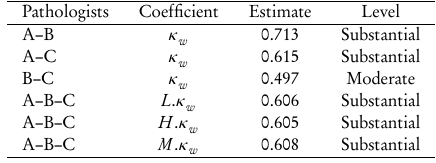
The results of weighted kappa coefficients.